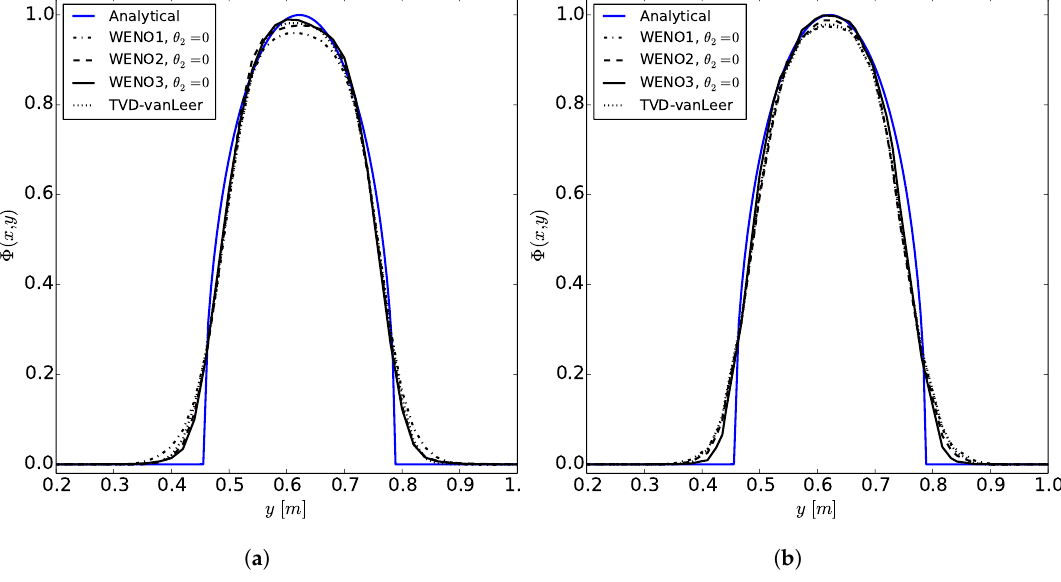
Figure 12. Slice of the ellipse -profile at x = 0.5 m. ( a ) 2500 squares; ( b ) 2204 triangles.